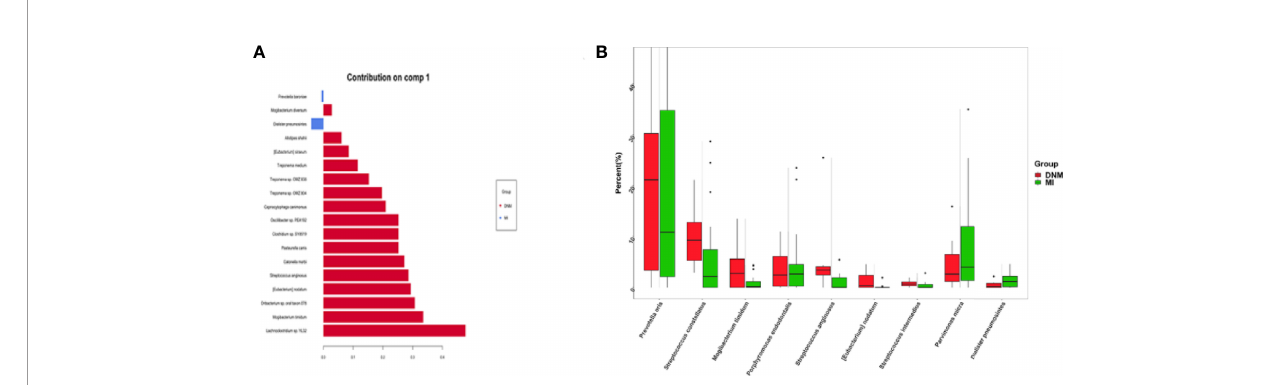
FIGURE 5 | Differential species screened in the sPLS-DA model. (A) species-level comp1 axial differential species, (B) 9 pathogenic species with high relative abundance in the differential